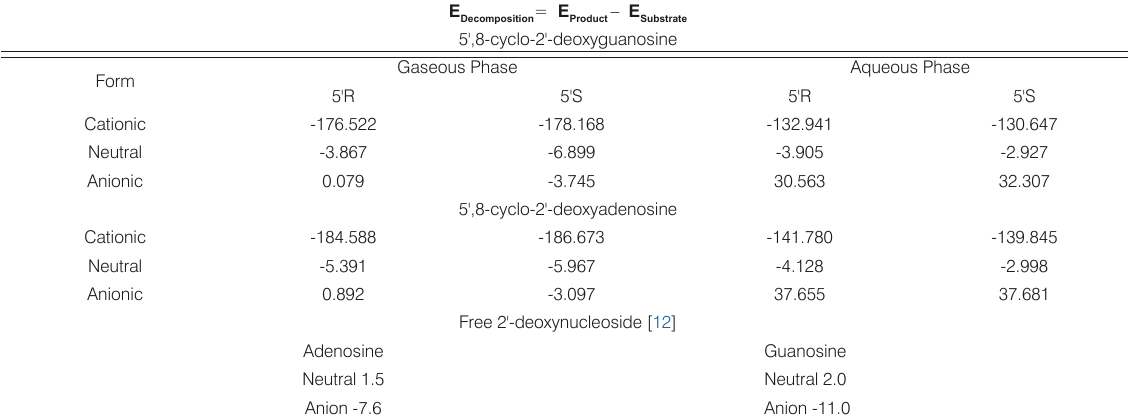
Figure 2. Possible mechanisms of N-glycosidic bond hydrolysis of the 5’,8-cyclopurine-2’-deoxynucleosides and IUPAC denotations of nucleophilic substitution. Table 1. Zero-point energy corrected enthalpies of the glycosidic bond hydrolysis of 5’,8-cyclo-2’-deoxynucleoside in kcal mol -1 calculated by